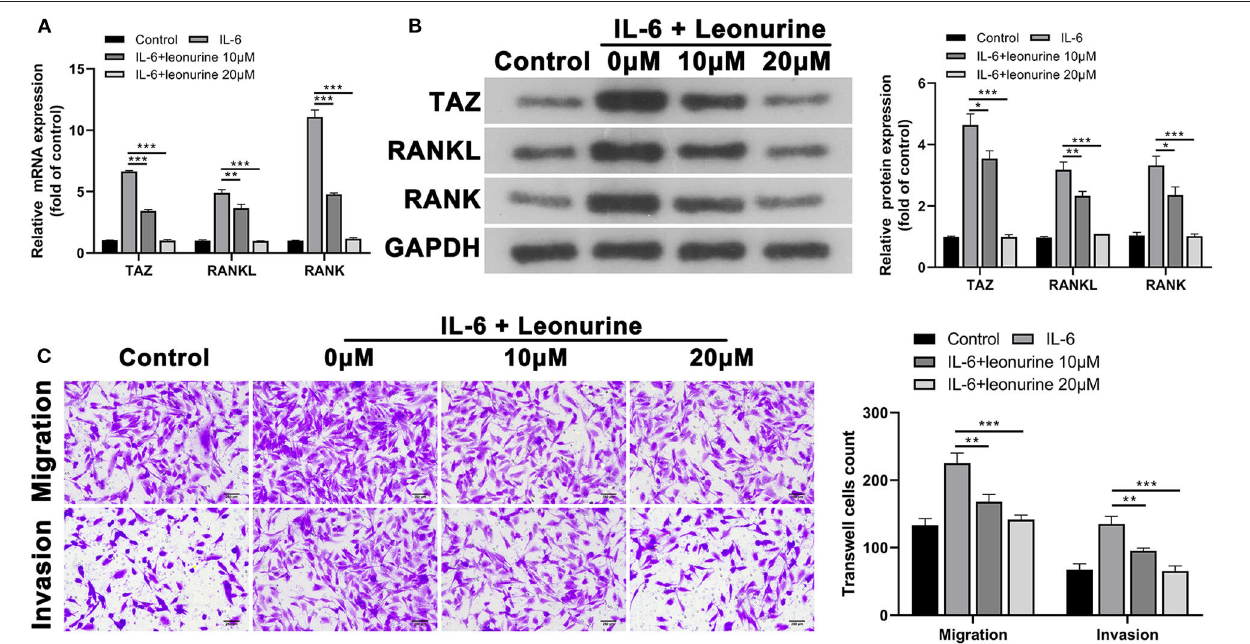
FIGURE 5 | Suppressive effect of leonurine on TAZ-mediated migration and invasion of synovial fibroblast-like cells. (A,B) qPCR and Western blot analysis showed that compared with that in the control group, TAZ, RANKL, and RANK by synovial fibroblast-like cells in the IL-6 group were all up-regulated. However, leonurine treatment (10 and 20 µ M) reduced the effects of IL-6 on TAZ/RANKL/RANK in a dose dependent manner. (C) Transwell (magnification, × 200) analysis showed that IL-6 promoted the migration and invasion ability of fibroblast-like cells, whereas leonurine treatment reduced the effect of IL-6. Results are expressed as the average of 3 experiments. * P < 0.05, ** P < 0.01, and *** P <